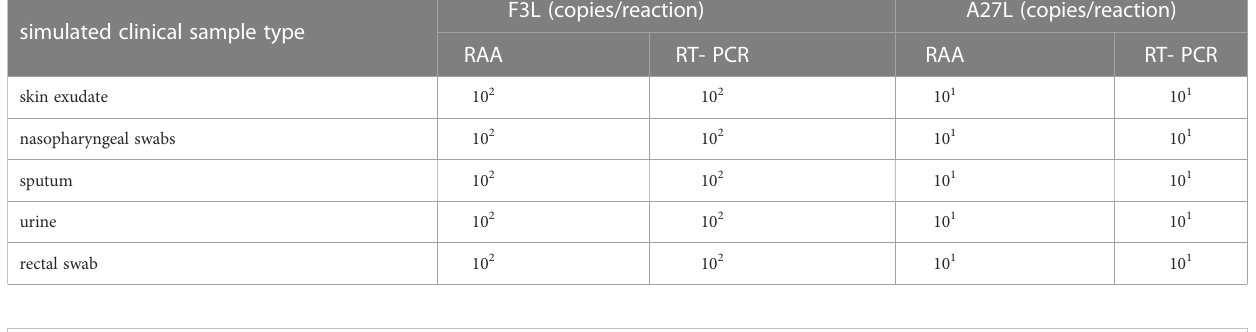
simulated clinical sample